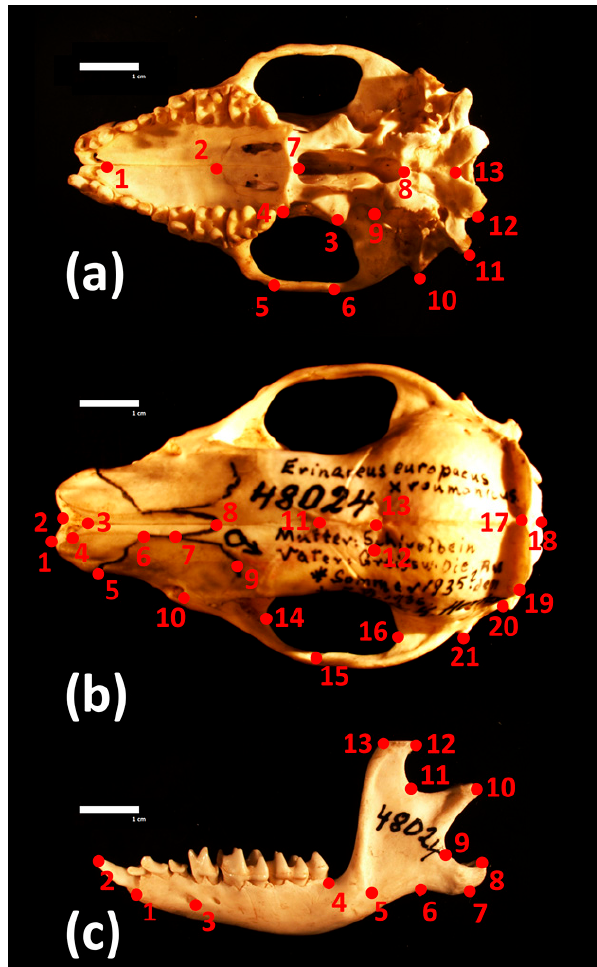
Figure 2. Location of the three-dimensional landmarks measured on ( a ) ventral and ( b ) dorsal sides of the cranium, and ( c ) the